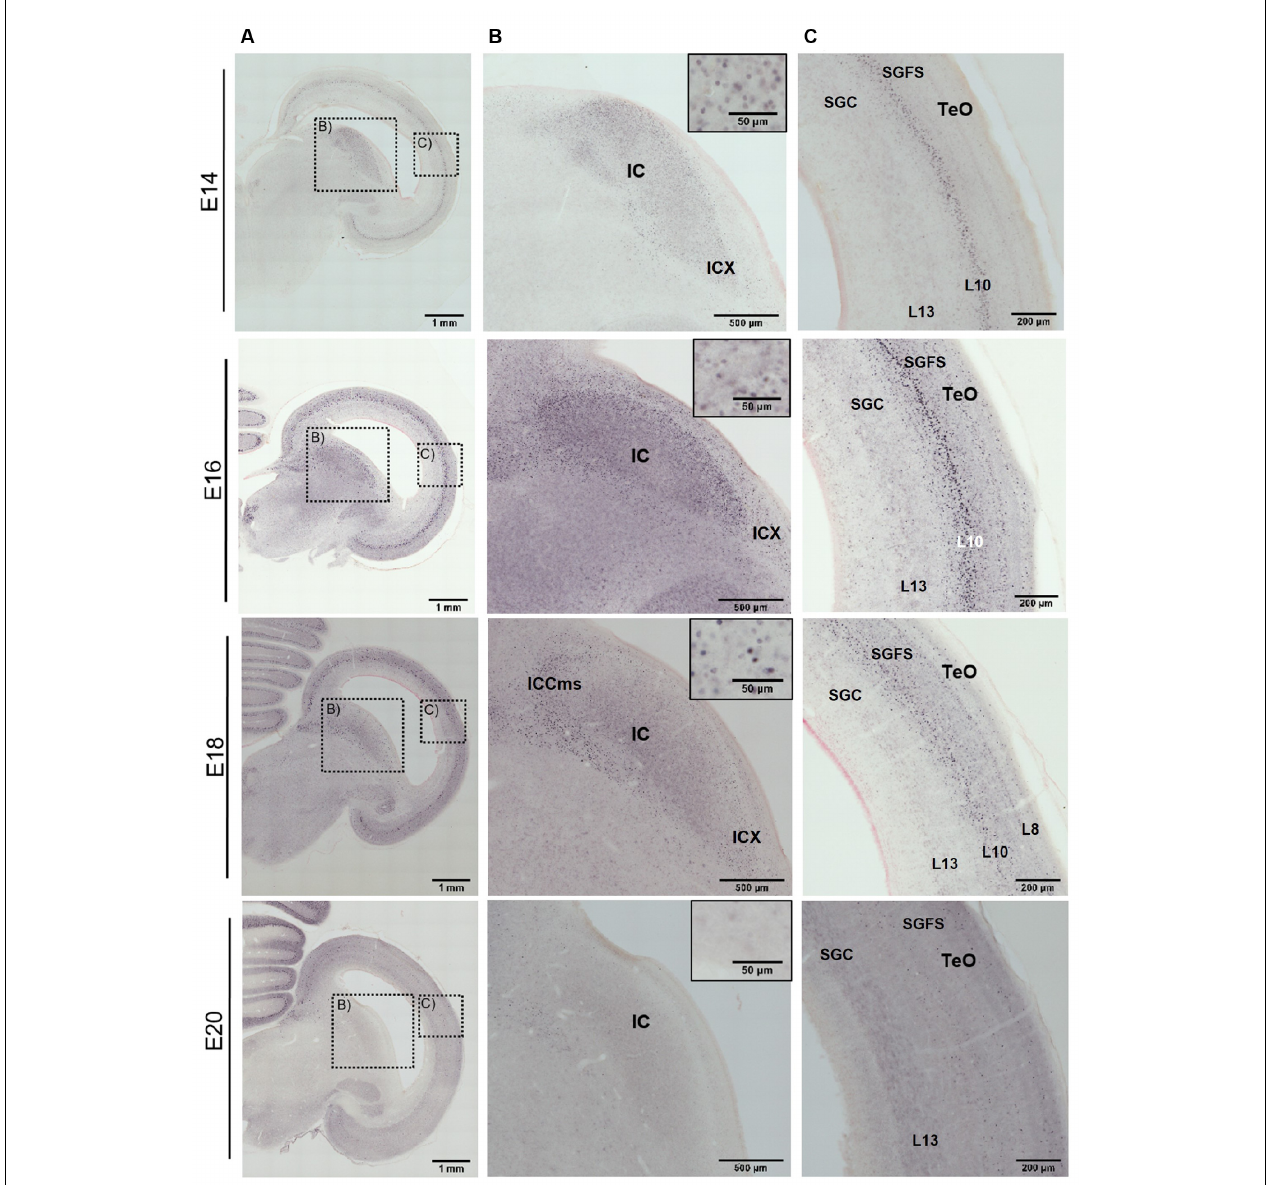
FIGURE 4 | Immunohistochemistry against AP-2 δ in chicken midbrains of E14–20 embryos. DAB staining, counterstain neutral red. (A) Frontal section of midbrain hemisphere. Scale bar 1 mm. (B) Labeling in the inferior colliculus (IC) and cell nuclei staining (inset). ICX, external nucleus of the IC; ICCms, medial shell of the central nucleus of the IC. Scale bars 500 µ m and 50 µ m. (C) Labeling in the optic tectum (TeO). SGC, stratum griseum centrale , SGFS, stratum griseum et fibrosum superficiale . Scale bar 200 µ